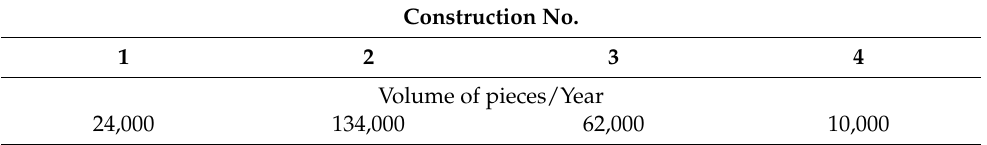
Table 5. Production volume of particular door constructions in the TechnoPORTA line in 2020. Construction